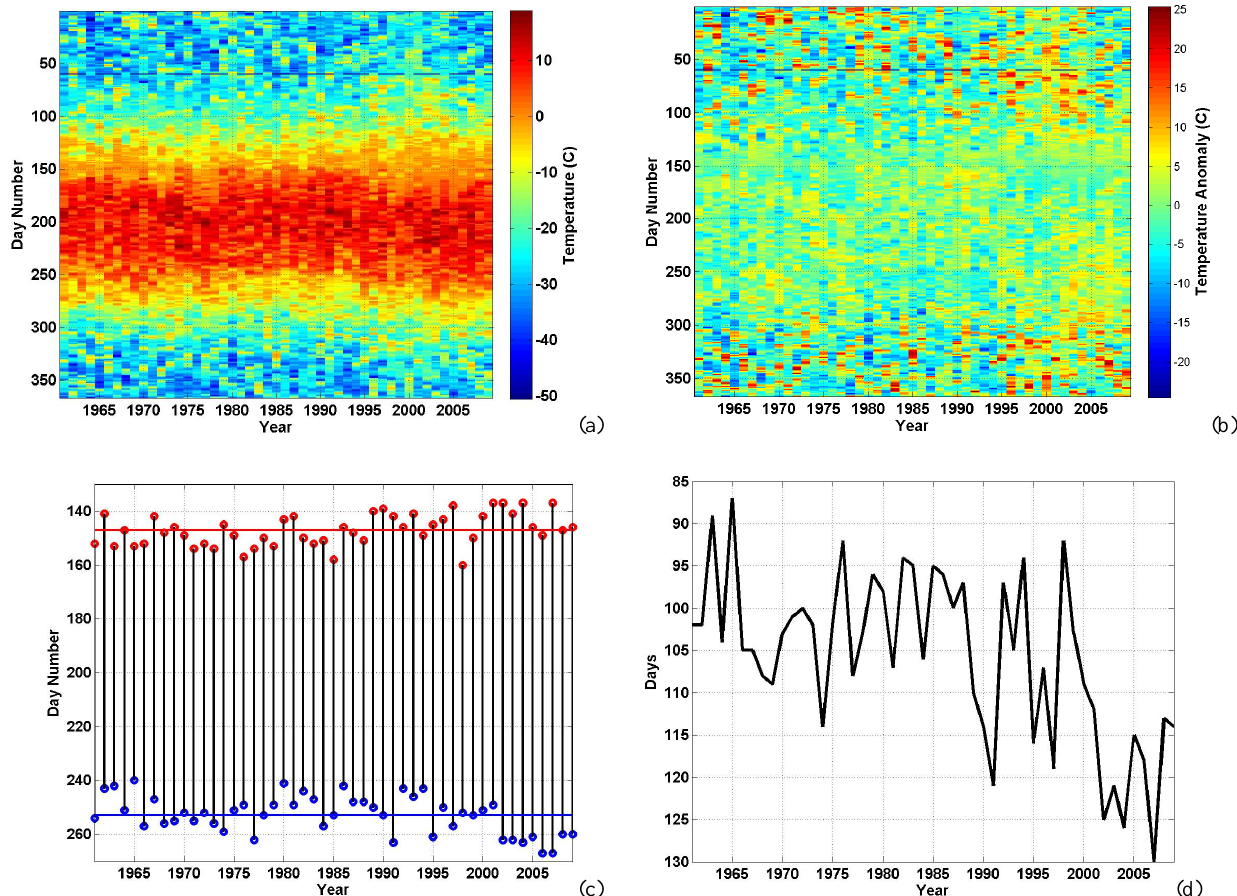
Fig. 2. Daily 2m NCEP air temperatures (a) and anomalies (b) at Lake El’gygytgyn. The anomalies, as described in the text, remove seasonal trends (e.g., summer is warmer than winter) and each daily anomaly can be compared to the weather pattern on that day (Fig. 1) to create pattern-averaged anomalies (Fig. 3a). Much of this paper deals with the warming (more yellows and reds) seen in spring and fall beginning around 1990 in (a) . (c) Thaw season start (red) and end (blue) dates for each year along with means (horizontal lines). (d) Length of thaw season in